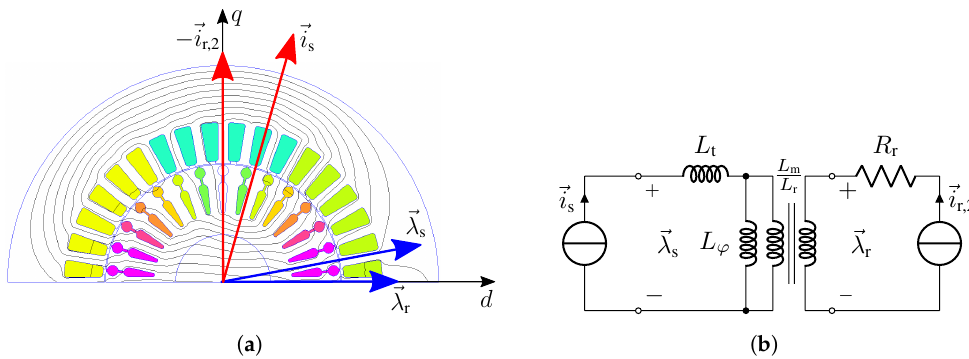
Figure 5. Second simulation field solution and related equivalent circuit, linked to the flux linkage– current relationships. ( a ) Second MS FEA field solution, imposed current density and flux lines are shown; ( b ) equivalent circuit related to the second MS FEA. Table 1. Results of the two-steps procedure, applied in different working